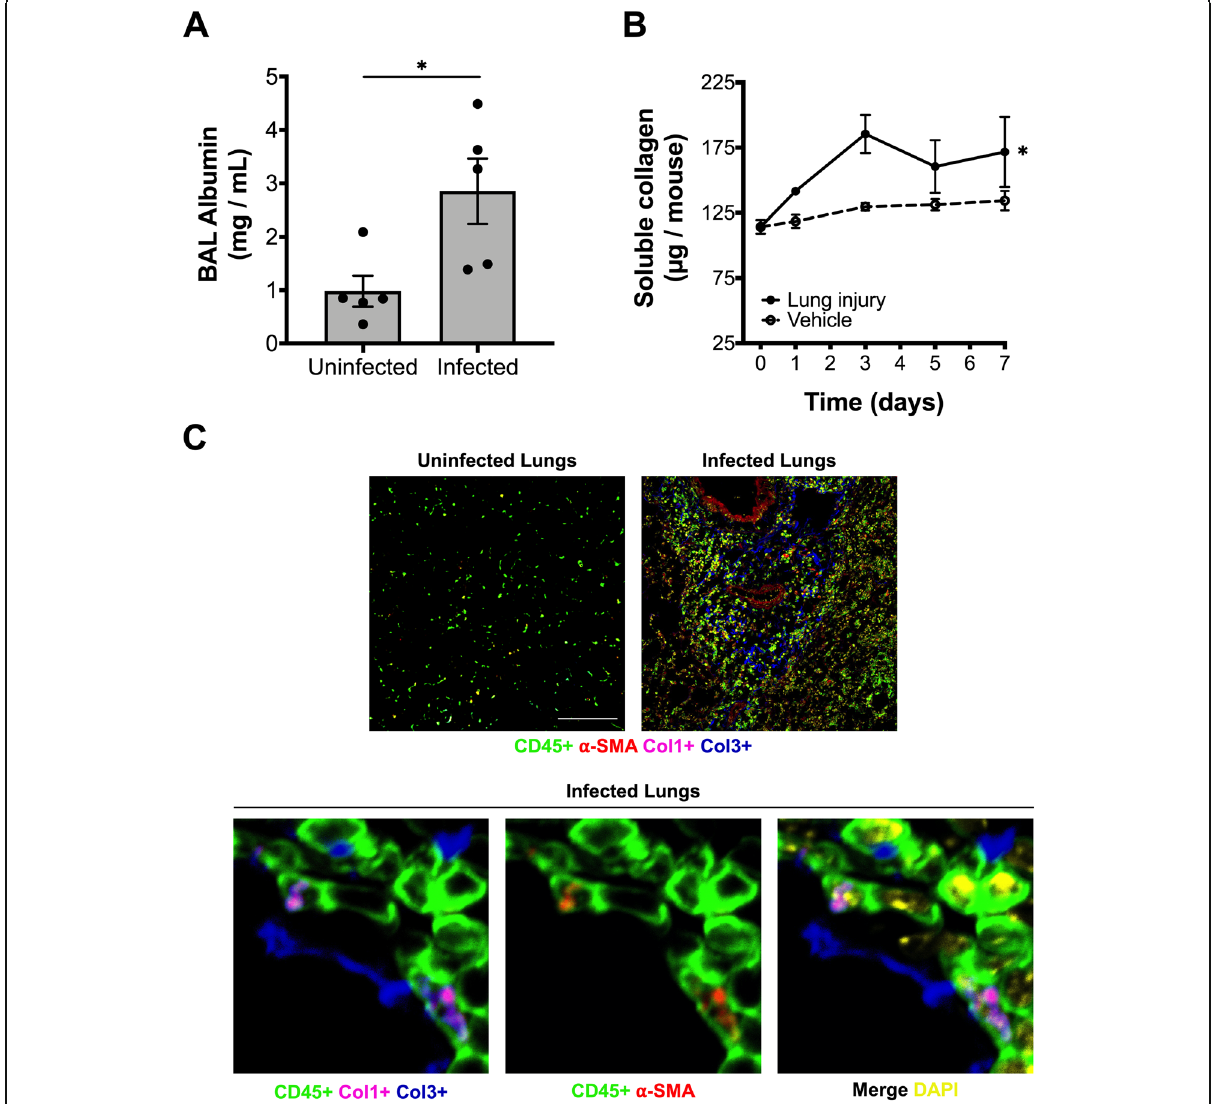
Fig. 1 Gram-negative pneumonia results in murine acute lung injury with changes in lung collagen content and localization of collagen- producing cells. a Bronchoalveolar lavage (BAL) albumin concentration on day 3 of acute lung injury caused by experimental Klebsiella pneumonia. Each dot represents one animal; mean and SEM are indicated. b Change in lung soluble collagen after onset of acute lung injury; n = 4 – 6 experimental animals per time point per group. c Initial panel at low power magnification (scale bar = 50 μ m) demonstrates lung immunofluorescent staining of normal (uninfected) lung tissue showing staining for CD45, N-terminal pro-collagen I (proCol1), collagen III (Col3), α -smooth muscle actin ( α -SMA), and nuclear stain (DAPI). Subsequent panels show high-power magnification demonstrate representative images on day 3 of lung injury. *, p < 0.05 by Mann-Whitney test (panel A) and 2-way ANOVA (panel